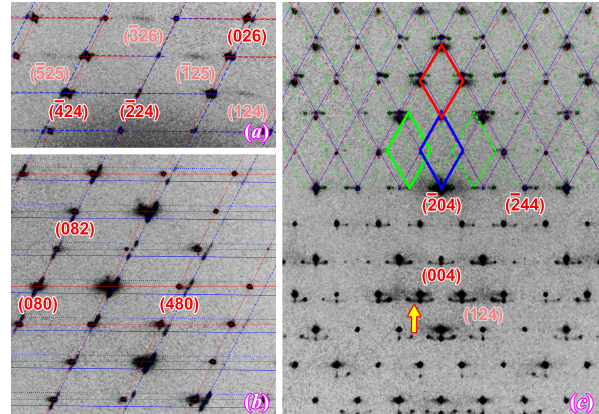
Figure 8. Off-centered sections of the reciprocal space showing some diffuse scattering features of the feldspar phases in Crys- tal 1. (a) h2l image of orthoclase showing diffuse streaking with h + k = 2 n + 1 that violates the C -centering lattice; (b) h8l image of orthoclase with reflection from the albite films (Pericline-twinned) showing obvious elongation along the [001] ∗ direction; (c) hk4 im- age of orthoclase with a diffuse arc connecting reflections from al- bite and oligoclase. The reciprocal lattices are marked by the same colors as in Fig.